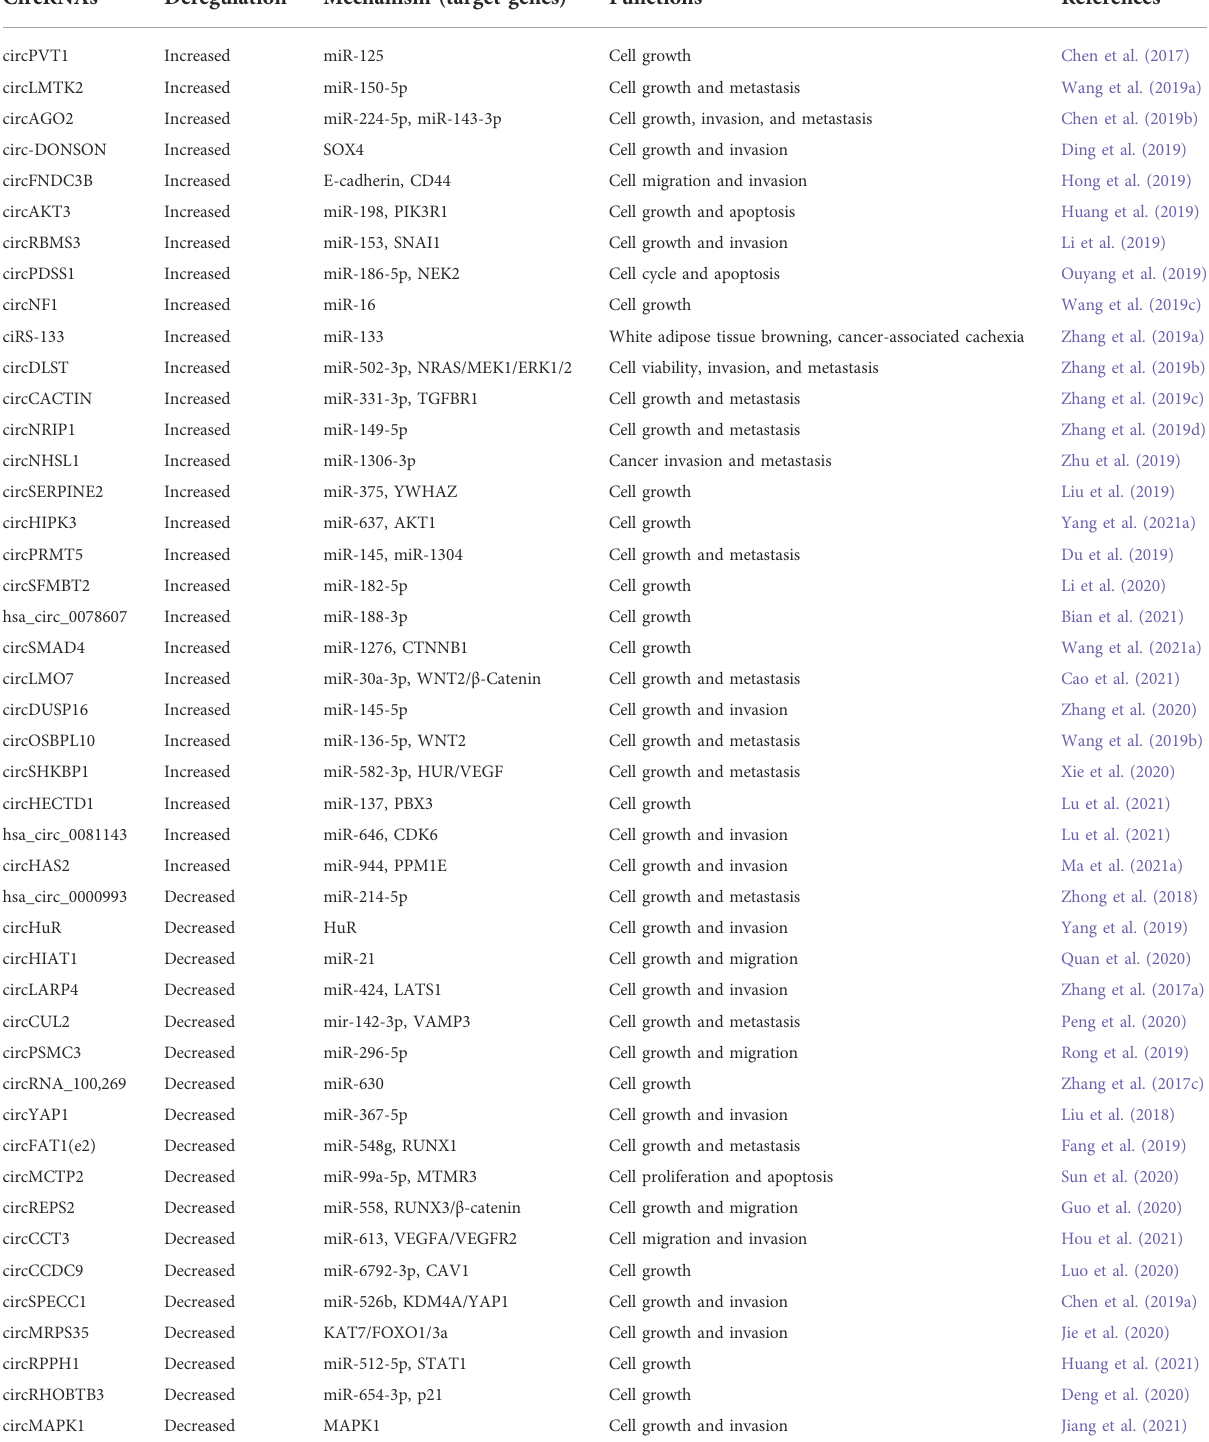
TABLE 1 CircRNAs associated with human gastric